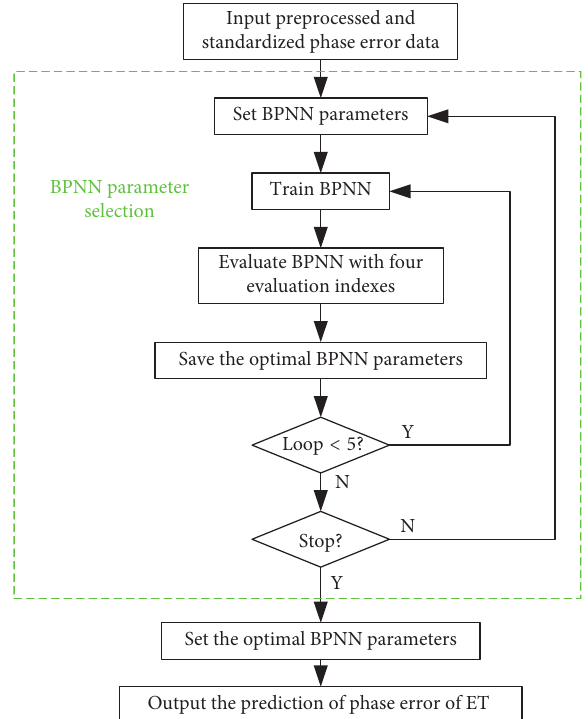
Figure 7: Flowchart of BPNN parameter selection and training.